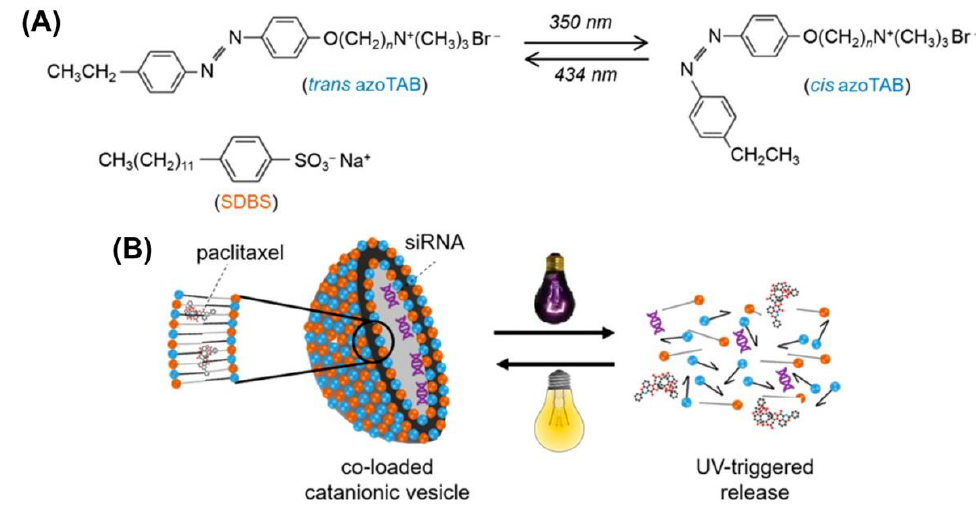
Figure 1. ( A ) Structure of azoTAB and SDBS surfactants, as well as the trans to cis photo-isomerization of azoTAB upon exposure to visible (434 nm) or UV (350 nm) light. The lengths of the alkyl spacers in azoTAB analogs are n = 2 (2-azo-2), n = 4 (2-azo-4), or n = 6 (2-azo-6). ( B ) Illustration of the reversible transition of cationic vesicles to free surfactants with UV illumination. Reproduced from [32] with permission, copyright 2020, American Chemical Society.